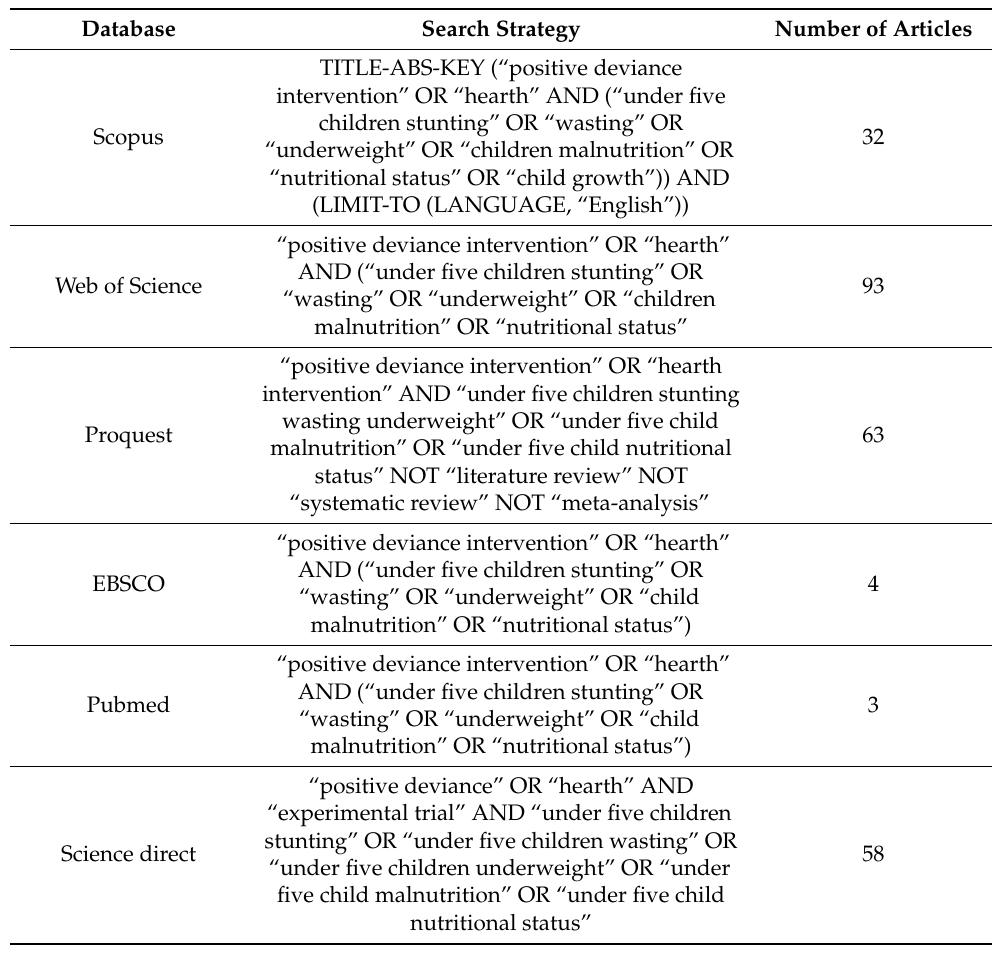
Table 1. Search strategy in selected